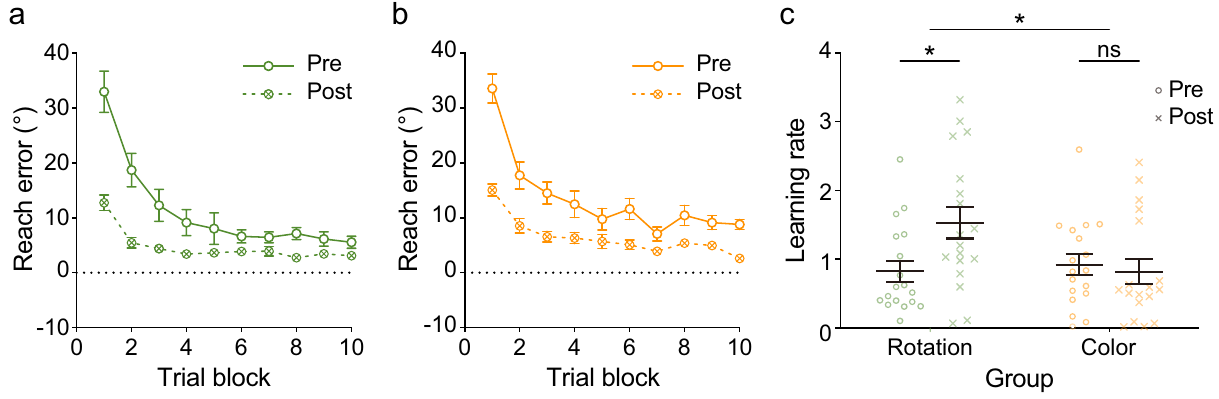
Figure 3. Results of Experiment 2. Reach error of VMR for the mental rotation group (a) and control color- discrimination group ( b ) in trial blocks 1–10 in the VMR pre-test and post-test. The pattern of lines and dots indicates test sessions (solid line/clear dot = pre-test, dotted line/crossed dot = post-test). ( c ) Learning rate (LR) of VMR tasks. Markers represent individual participants in the pre- (circle) and post-test (cross). Black horizontal lines represent the mean with standard errors of the mean in the corresponding group. In ( a )–( c ), the colors of the dots and lines correspond to visual training groups (green = mental rotation, orange = control color- discrimination). Error bars indicate standard errors of the mean. An asterisk indicates significant difference between results for the two training groups (* p <